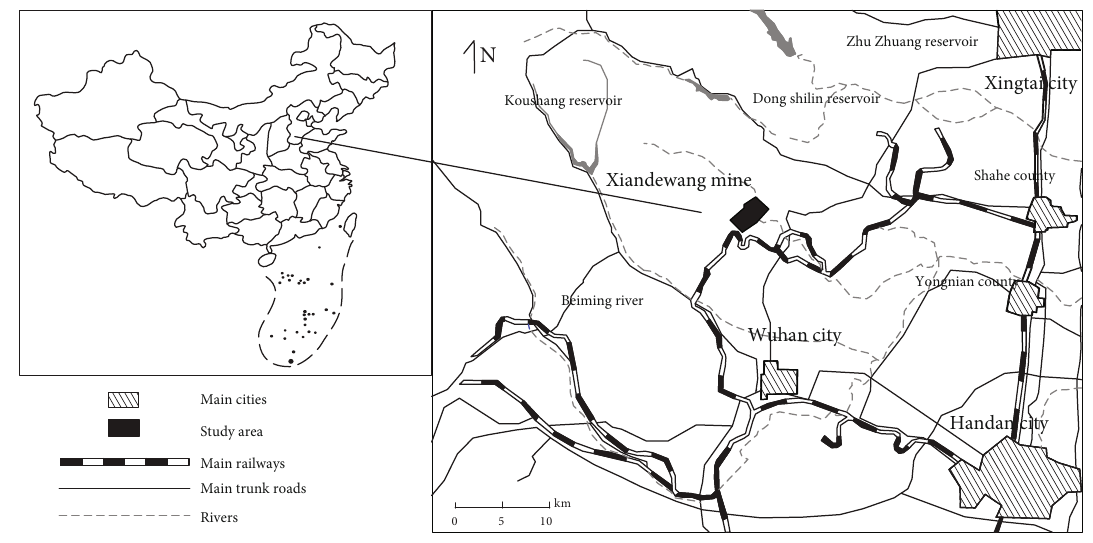
Figure 1: Tra ffi c location. Table 1: Training sample data (unit: